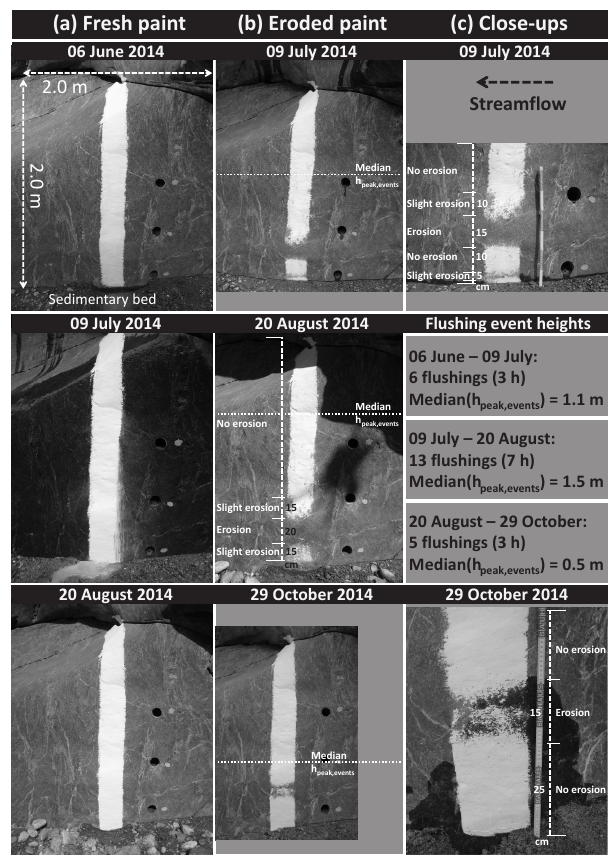
Figure 3. Painted stripe R2 on the right gorge wall (cf. Fig. 1d), in- dicating a zone of complete paint erosion at ∼ 15–40cm above the stream bed, suggesting a temporary sediment cover effect at the bot- tom due to bed aggregation during flushings and a constrained sed- iment tools effect on top, causing lateral erosion: column (a) shows stripe R2 freshly painted on three dates, column (b) shows the same stripe after 4–10 weeks of flushing events, and column (c) shows close-up views of the erosion zone along with information on the flushing events for each of the three time periods. The dotted lines in column (b) locate the median of peak flushing heights per period (median h peak,events